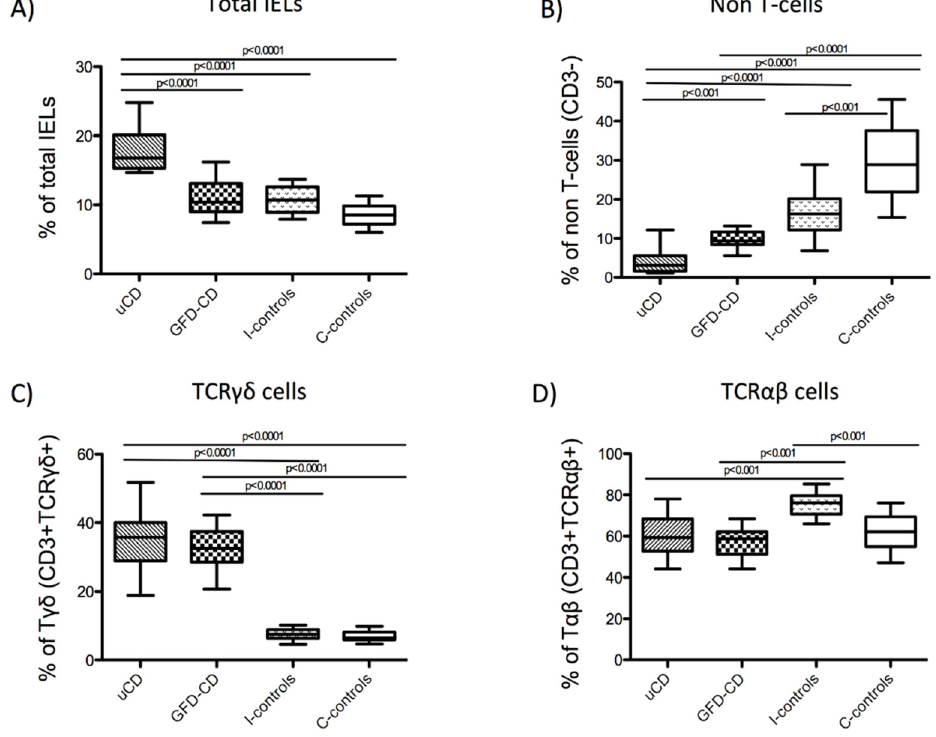
Figure 5. Cont. Figure 5.